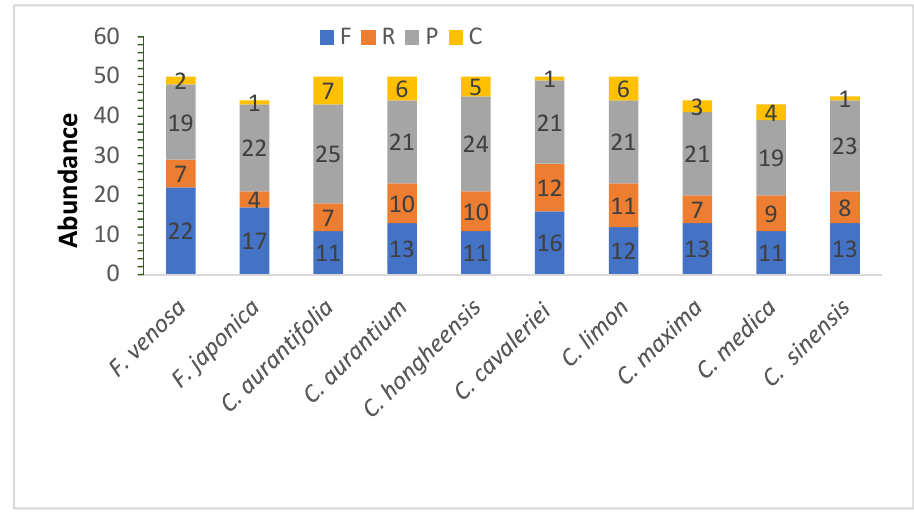
Figure 2. Comparison of repeated sequences in ten Rutaceae chloroplast genomes (Type and abun- dance of long repetitive sequences). Note: C represents complementary repeats, F represents Forward repeats, R represents reverse repeats, P represents palindromic repeats.